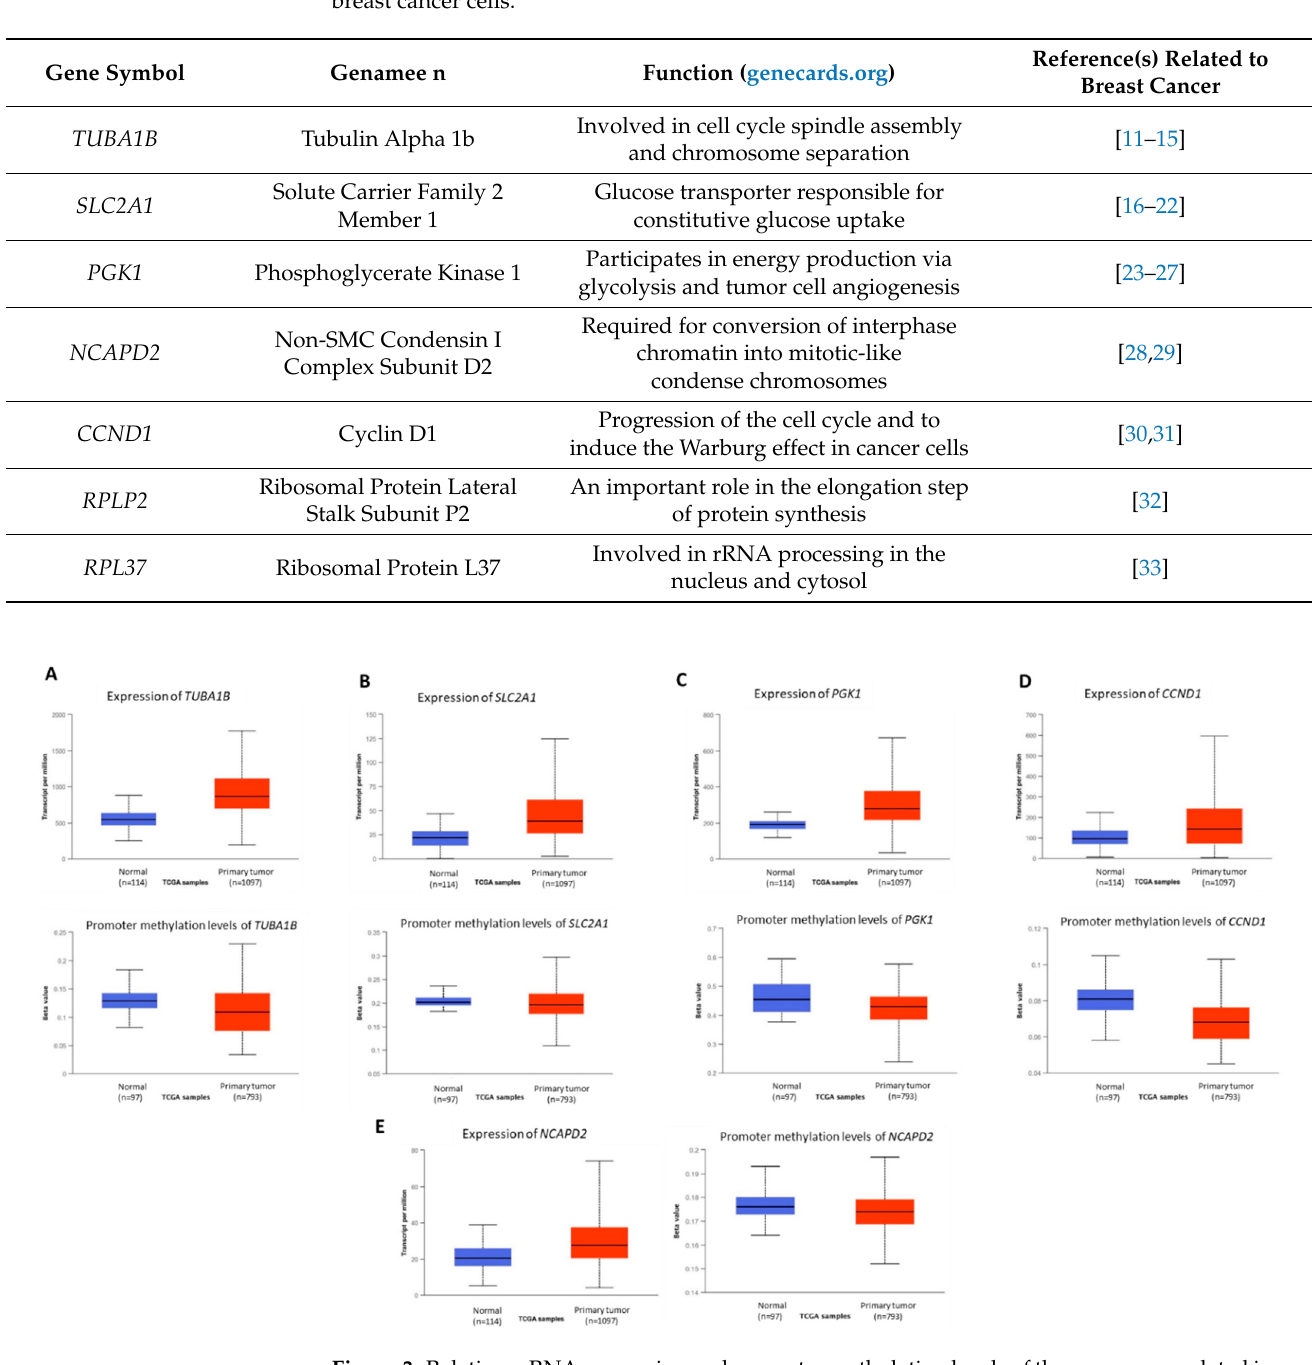
Figure 3. Relative mRNA expression and promoter methylation levels of the genes upregulated in cancer cells but downregulated by crocodile serum. ( A ). TUBA1B , ( B ). SLC2A1 , ( C ). PGK1 , ( D ). CCND1 , ( E ). NCAPD2 . (Note: for all the box-plots, p < 0.001).